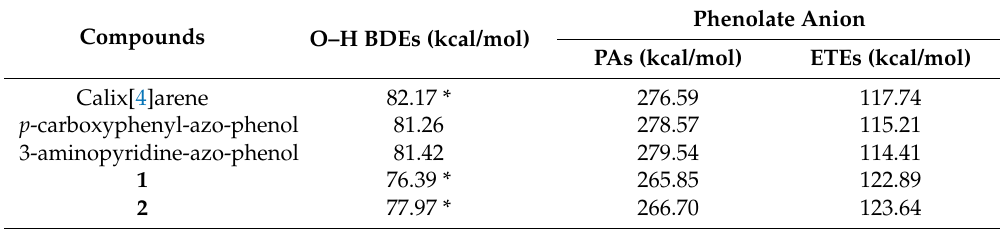
Table 1. The calculated phenolic O–H bond dissociation enthalpies (BDEs) and proton affinities (PAs) of phenolate anions of investigated chemical systems at BP86/6-311+G(d,p) level of theory.